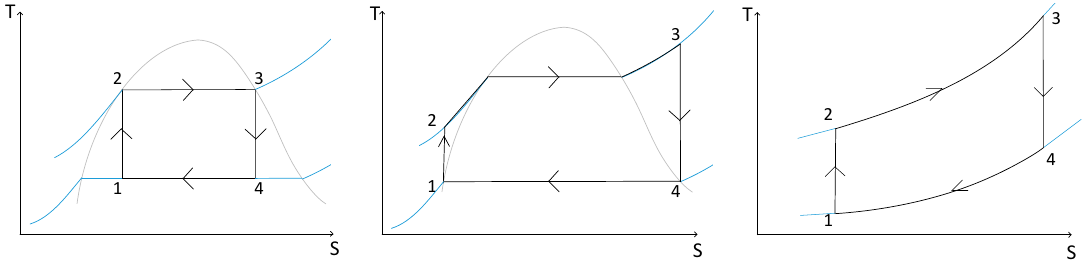
Figure 4. Carnot cycle ( left ), Rankine cycle ( middle ), and Brayton cycle ( right ). 1 → 2: isentropic compression, 2 → 3: isobaric heat transfer with hot source, 3 → 4: isentropic expansion, 4 → 1: isobaric heat transfer with cold source. Grey and blue curves describe conditions of phase coexistence and isotherms, respectively.